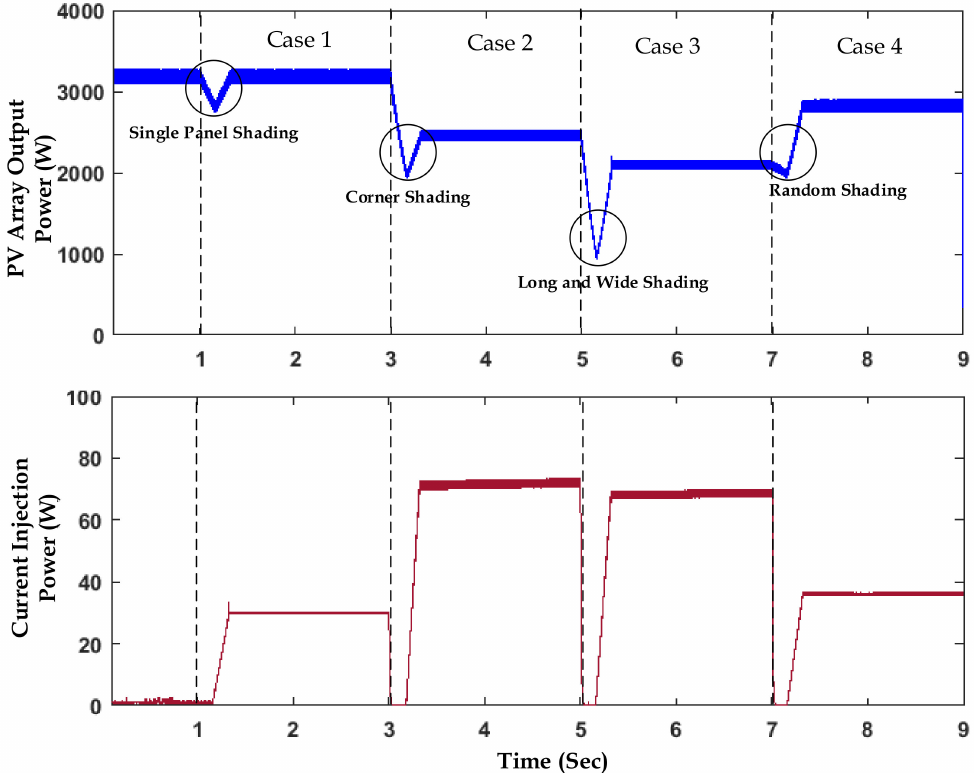
Figure 13. HBCI power output and power consumption during the injection of current for the shading cases (Note: the different schemes have a 2 s gap).